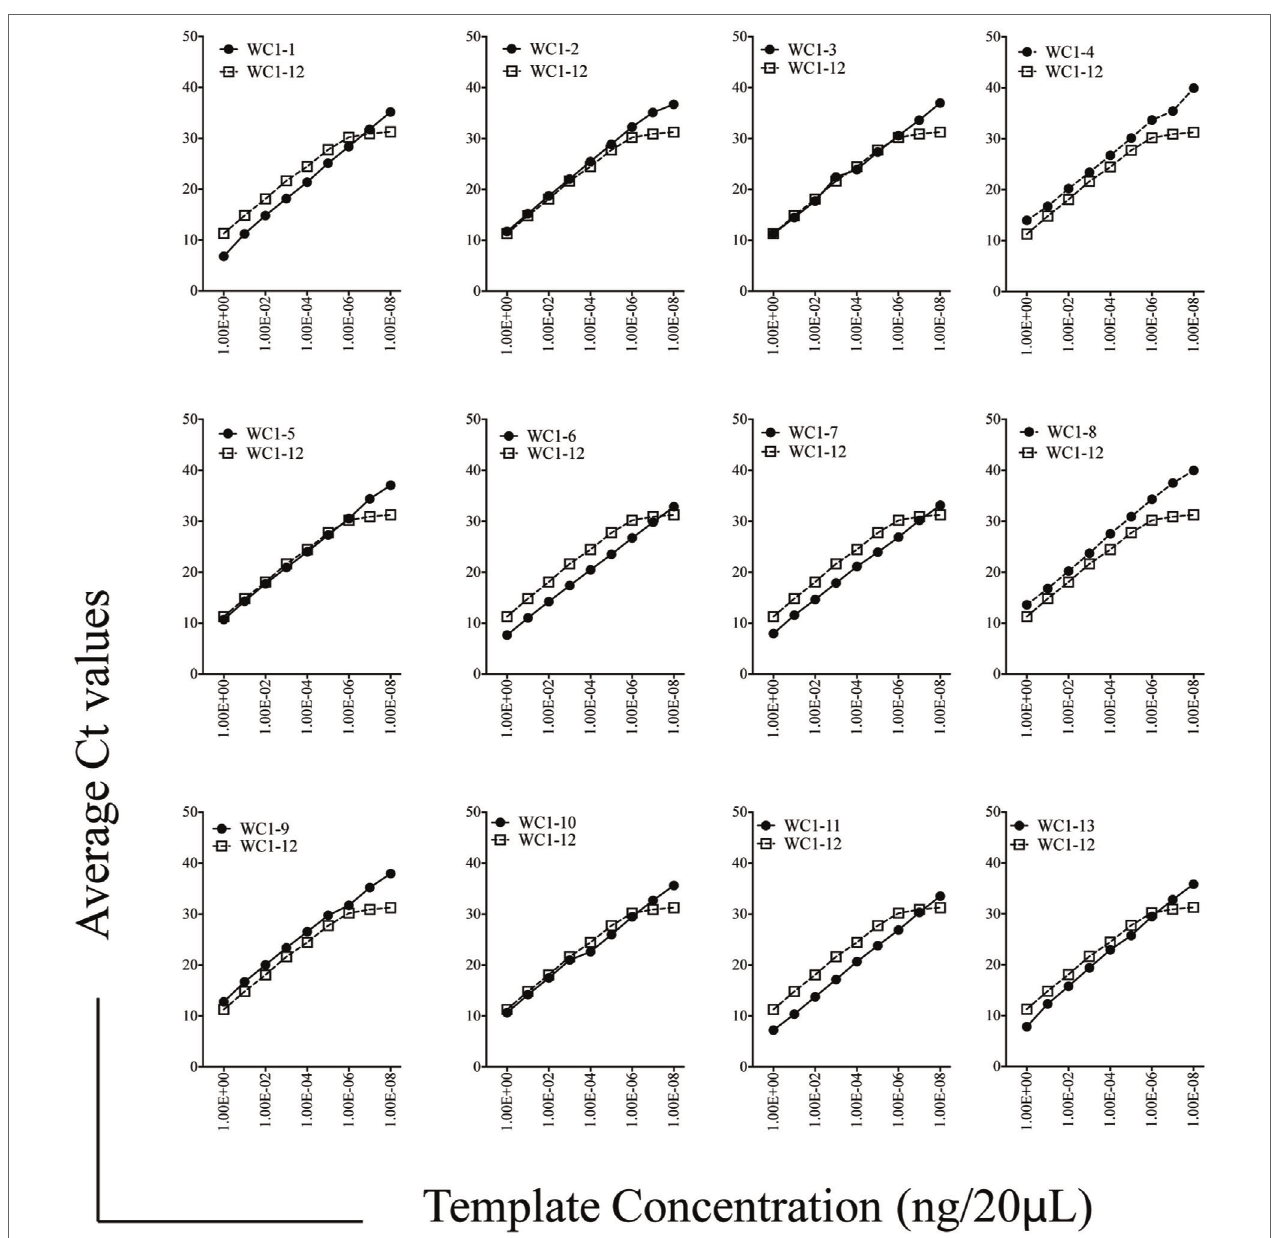
FigUre 1 | Efficiency of Taqman assays for WC1 transcripts. Standard curves for individual WC1 genes’ scavenger receptor cysteine rich a1 domains were amplified and detected with the Taqman primer/probe assays using serially diluted pST2a-WC1 templates. In each case, WC1-12 efficiency is shown as a